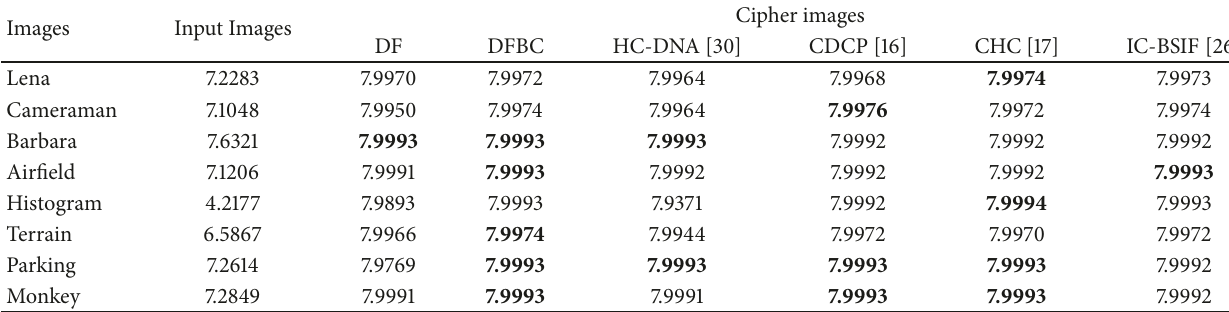
Figure 7: Decrypted images of Lena, Cameraman, Monkey, and Parking. The first row is with correct keys: 𝑥 0 1 = 0 , 𝑥 0 2 = 0.1 , 𝑥 0 3 = 0.2 , 𝑥 0 = 0.3 , 𝑥 0 = 0.5 , 𝑥 0 = 0.6 , and 𝑥 0 = 0.7 . The second row is with slightly different keys: 𝑥 1 4 5 6 7 𝑥 1 = 0.6 , and 𝑥 1 = 0.7 . 6 7